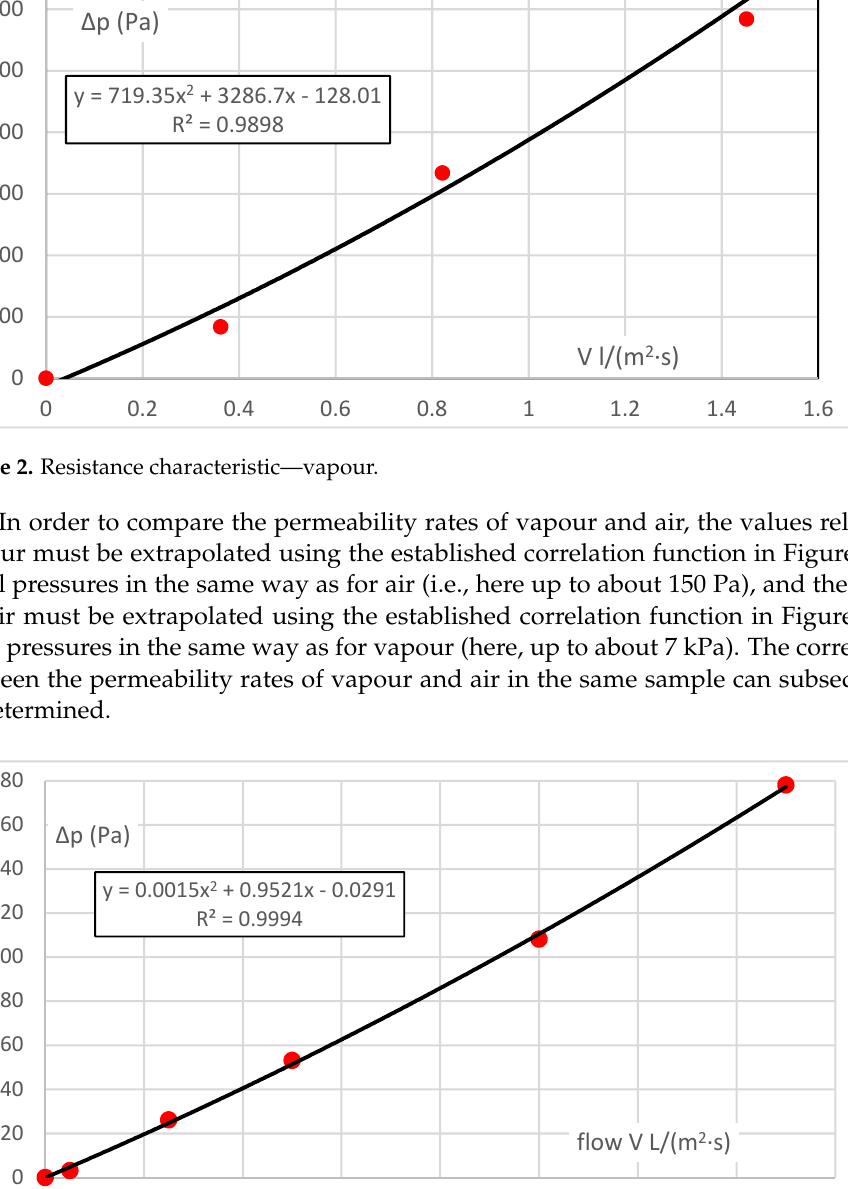
Figure 2. Resistance characteristic—vapour.